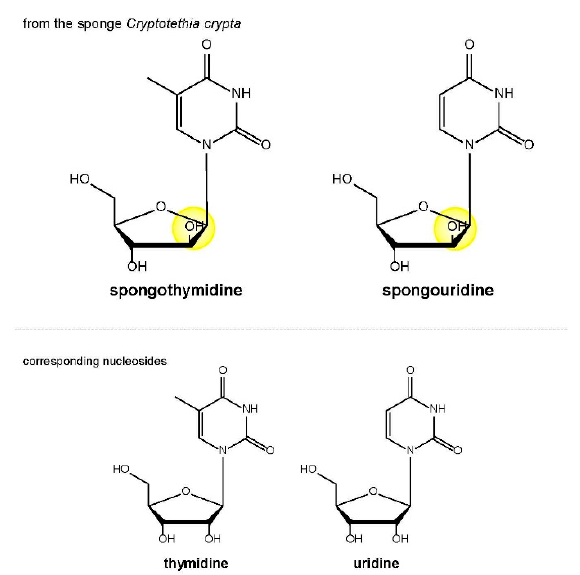
Figure 2. Chemical structures of arabinosyl nucleosides from the sponge Cryptotethia crypta , together with the corresponding human nucleosides. The key structural features are highlighted in yellow. Arabinosyl nucleosides contain arabinofuranose instead of β - D -ribofuranose.